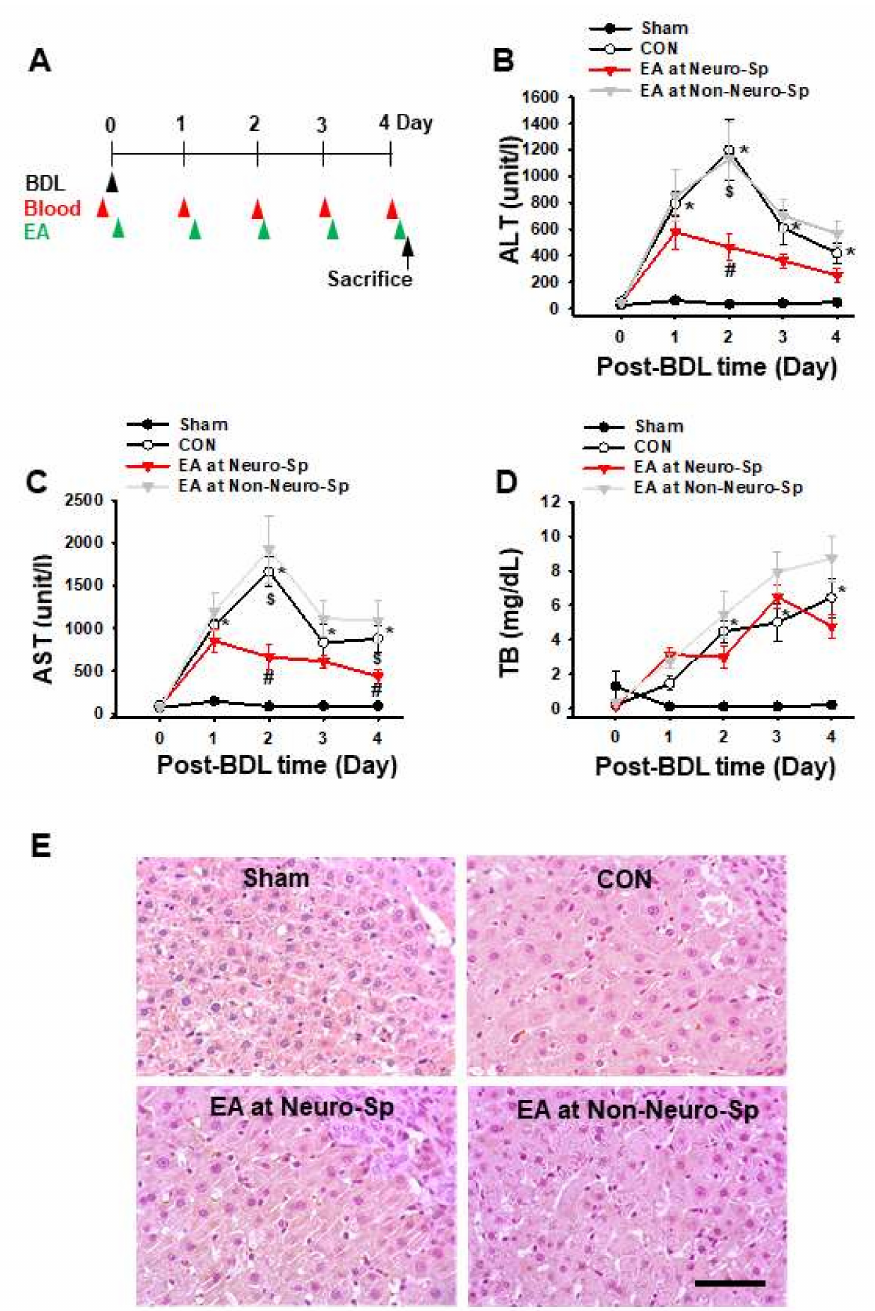
Figure 5. Effect of electroacupuncture at neurogenic spots on BDL-induced hepatic injuries. ( A ). Ex- perimental schedule. BDL, bile duct ligation; Blood, blood sample from jugular vein; EA, elec- troacupuncture. ( B – D ). Effect of electroacupuncture at neurogenic spots on the levels of ALT (alanine transaminase, ( B )), AST (aspartate transaminase, ( C )) and TB (total bilirubin, ( D )) in BDL rats. * p < 0.05, Sham vs. CON; # p < 0.05, CON vs. EA at Neuro-Sps, $ p < 0.05, EA at Neuro-Sps vs. EA at Non-Neuro-Sp. n = 6/group. ( E ). Histological examination of EA effects at neurogenic spots on BDL-induced liver injury. Hematoxylin and Eosin staining of liver tissue. Bar = 50 µ m. Sham (sham surgery), CON (BDL rats), EA at Neuro-Sps (EA at neurogenic spots in BDL rats) and EA at Non-Neuro-Sp (EA at nearby sites 5 mm apart from neurogenic spots in BDL